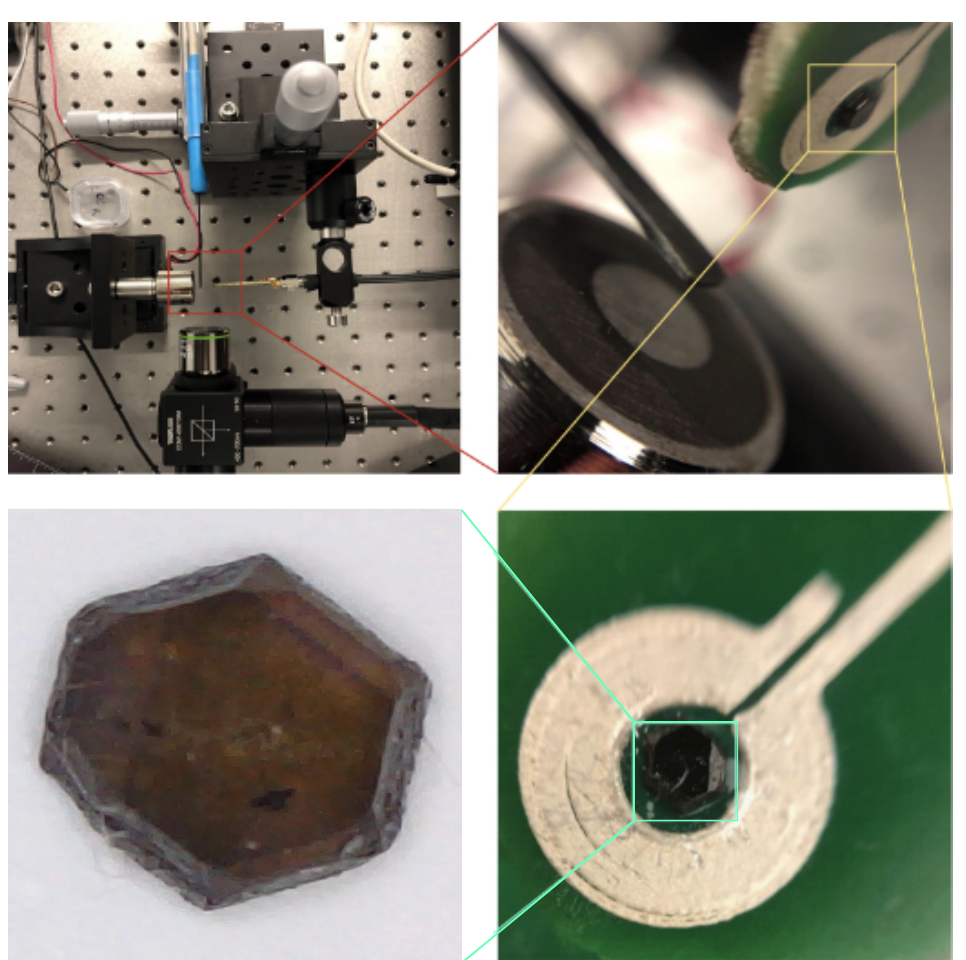
Figure 4. Four views of the experimental setup at different levels of detail. Upper left: experimental setup including the teslameter probe (blue), electromagnet (left), objective (down), XYZ positioner (up) and resonator with diamond (center); Upper right: details of the electromagnet, the teslameter probe and the resonator with the diamond; Lower right: the resonator silver printed on the PCB with a diamond in the middle; Lower left: a zoom image of the single crystal diamond